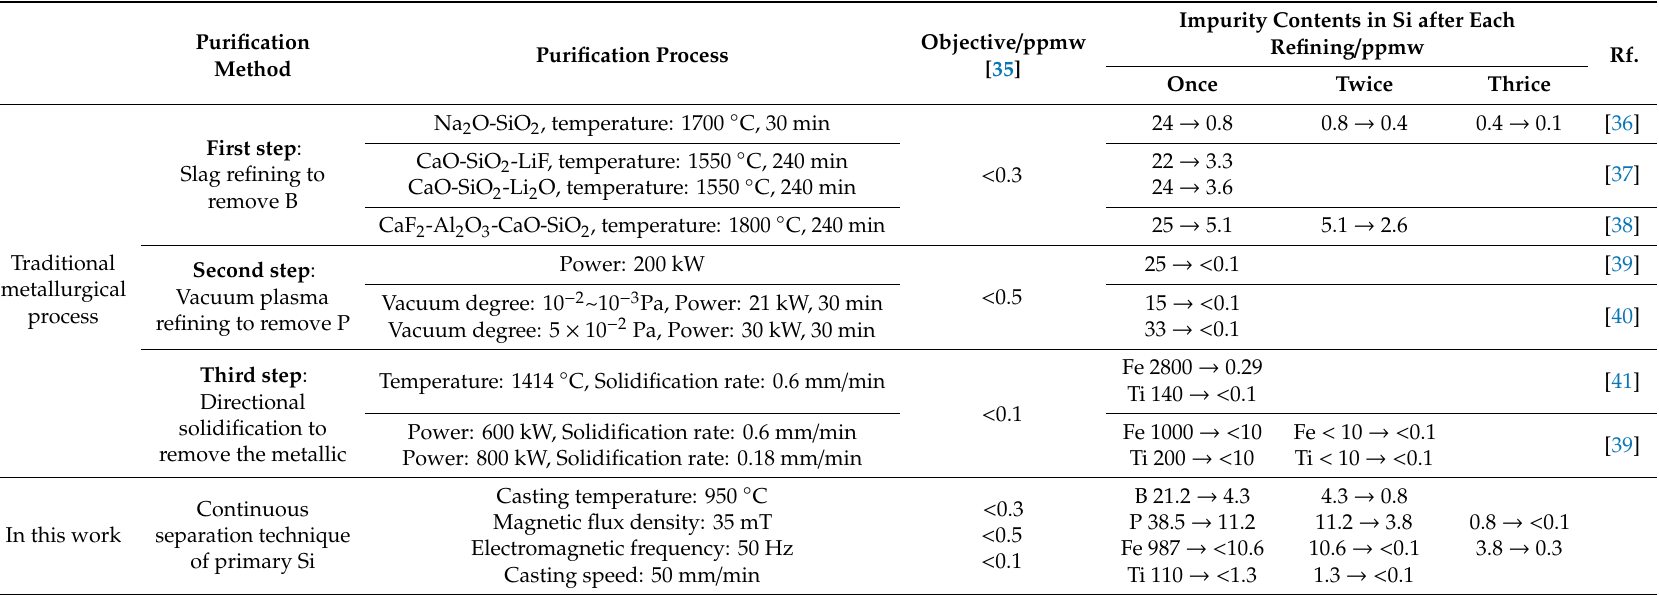
Table 2. The summary of the impurity removal e ff ect by the traditional metallurgical method and continuous separation technique of primary